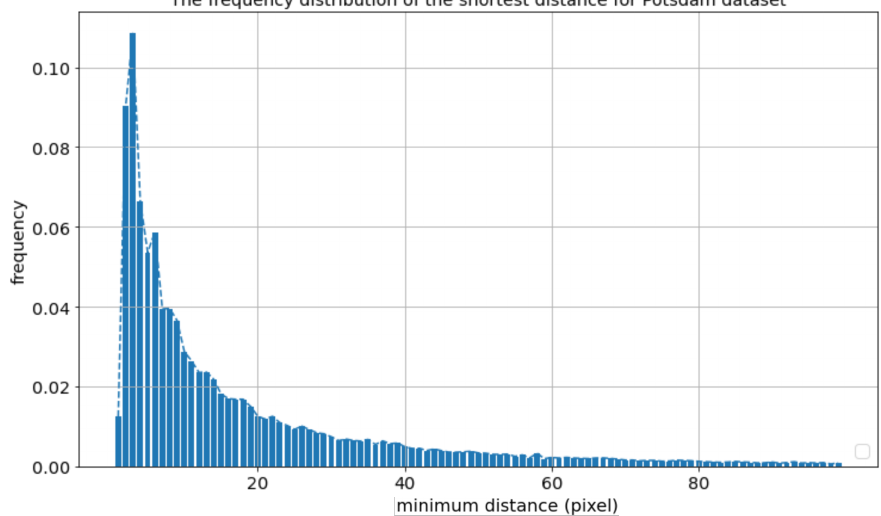
Figure 6. Distribution of the minimum distance with HRNet32-OCR [44] as the backbone on the Potsdam dataset. We sampled the clicks generated in each corrective sampling